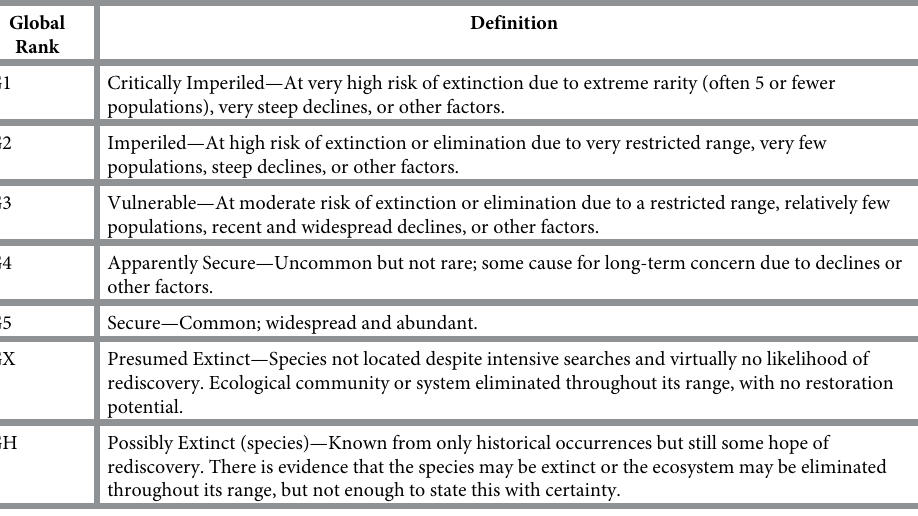
Table 1. Conservation status ranks used in the NatureServe methodology [45,46]. From http://www.natureserve. org/conservation-tools/conservation-status-assessment. At the subnational level, S-ranks are used. Global